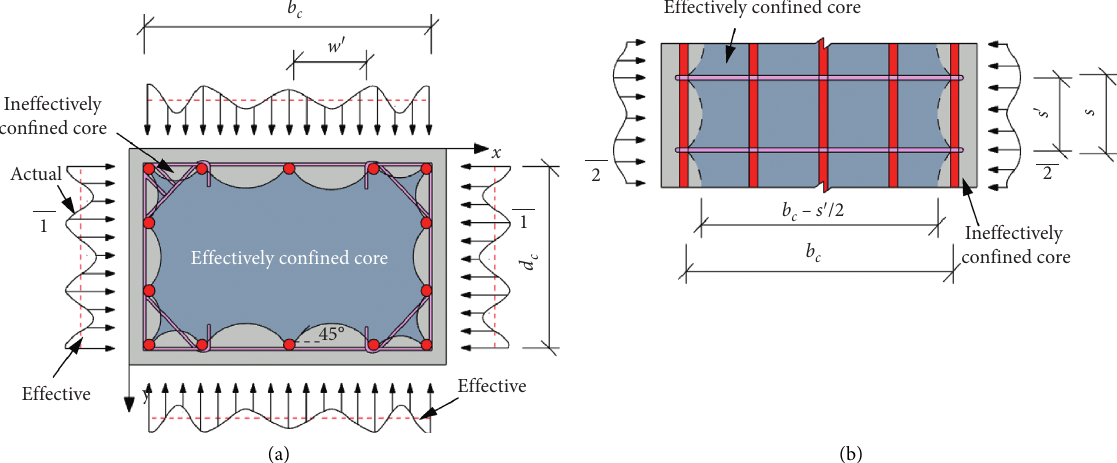
Figure 8: Effectively confined core for rectangular stirrup: (a) Section 2-2 and (b) Section 1-1.